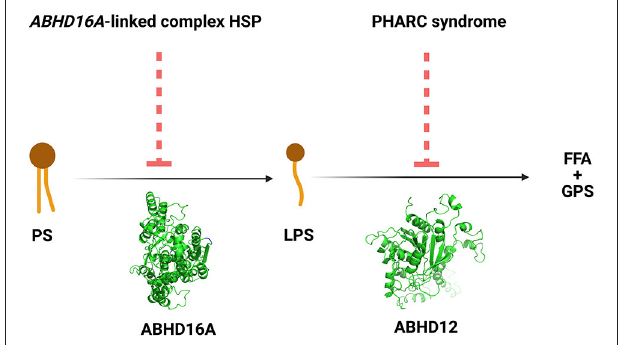
FIGURE 3 | The reactions and the disorders across the ABHD16A-ABHD12 pathway. HSP, hereditary spastic paraplegia; PHARC syndrome, syndrome of polyneuropathy, hearing loss, ataxia, retinitis pigmentosa, and cataract; PS, phosphatidylserine; LPS, lysophosphatidylserine; FFA, free fatty acid; GPS,